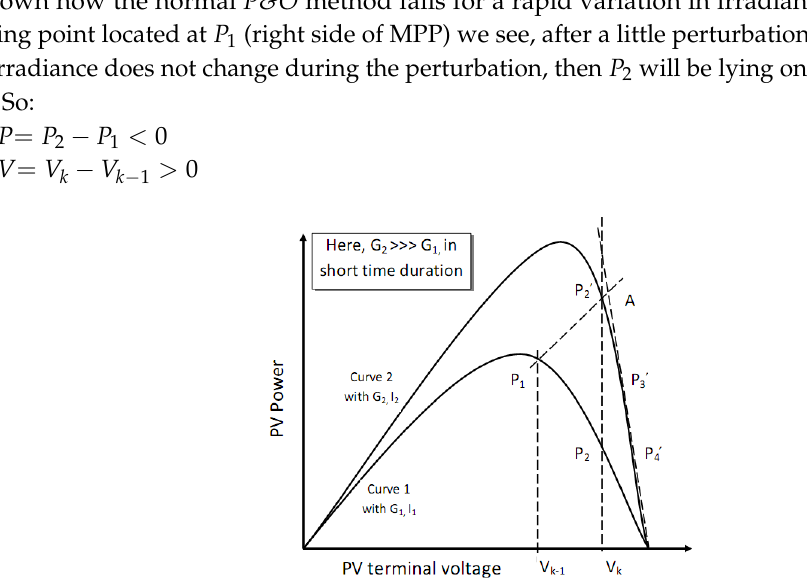
Figure 4. Response of Proposed method for rapidly increasing